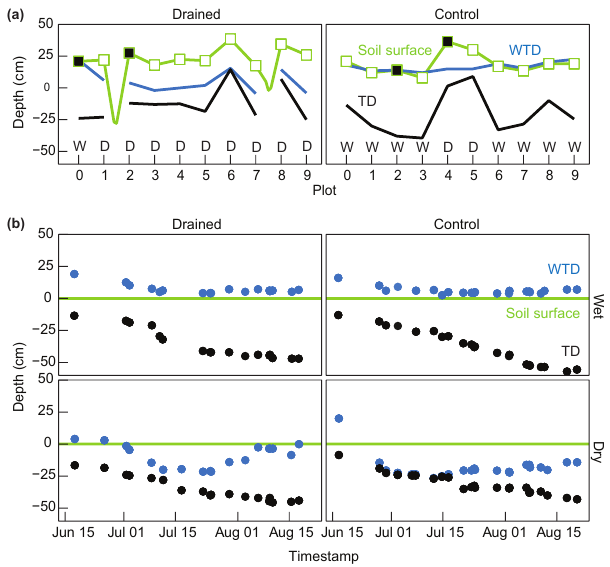
Figure 3. (a) Spatial variability in WTDs and TDs measured across the two transects on 10 August 2013. Plots are indicated with squares (core plots indicate closed squares). The letters W and D indicate the wet and dry WTD category of each plot, respectively. (b) Temporal variability in WTD and TD observed at the four core plots over the growing season of 2014, separated by transect (columns) and WTD category